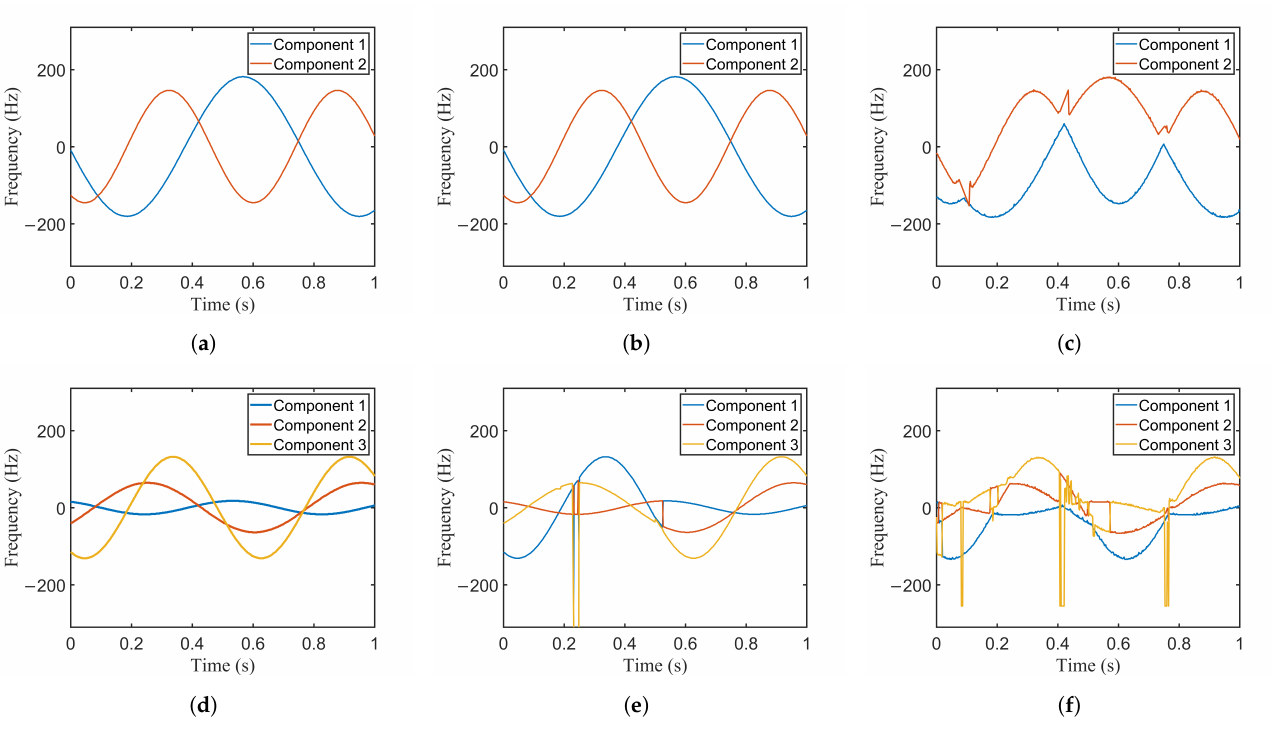
Figure 8. Ridge correlation results by different methods. ( a – c ) Result of ridge segment linking, the RPRG, and the Viterbi algorithm for a two-component signal. ( d – f ) Result of ridge segment linking, the RPRG, and the Viterbi algorithm for a three-component signal.